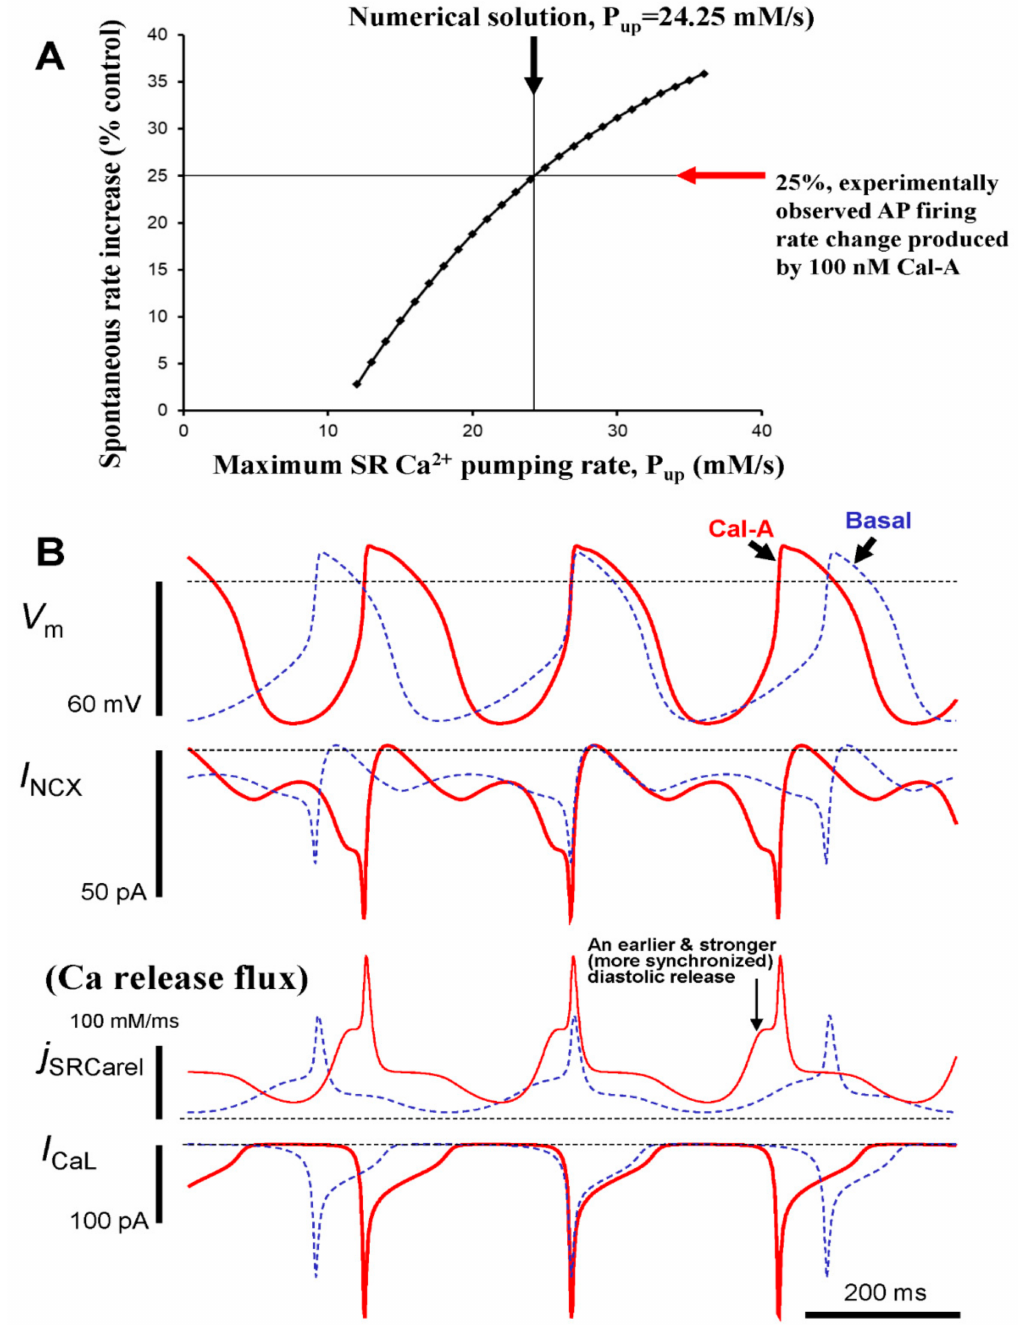
Figure 9. Numerical model simulations of the experimentally defined effects of protein phosphatase inhibition by CyA on spontaneous AP firing rate of rabbit SANC. ( A ) A numerical solution in which the maximum SR Ca 2+ pumping rate, P up was increased to 24.25 mM/s, reproduced the experimentally observed increase in AP firing rate by 25% in the presence of 100 nM of CyA. ( B ) Simulations of the membrane potential (V m ), NCX current (I NCX ), L-type Ca 2+ current (I CaL ), and Ca 2+ release flux (j SRCarel ) before (dashed line) and during CyA application (CyA, solid